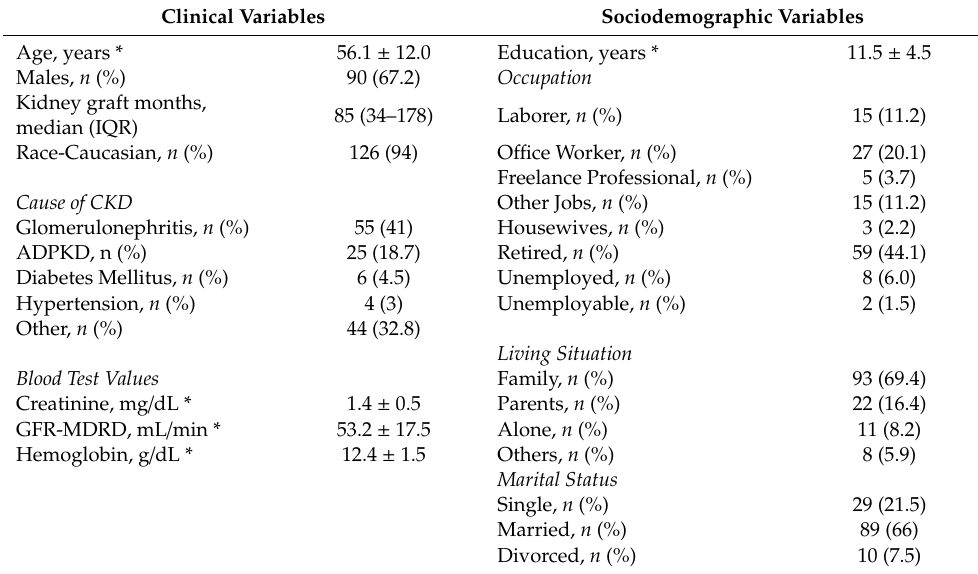
Table 2. Sociodemographic and clinical variables of the